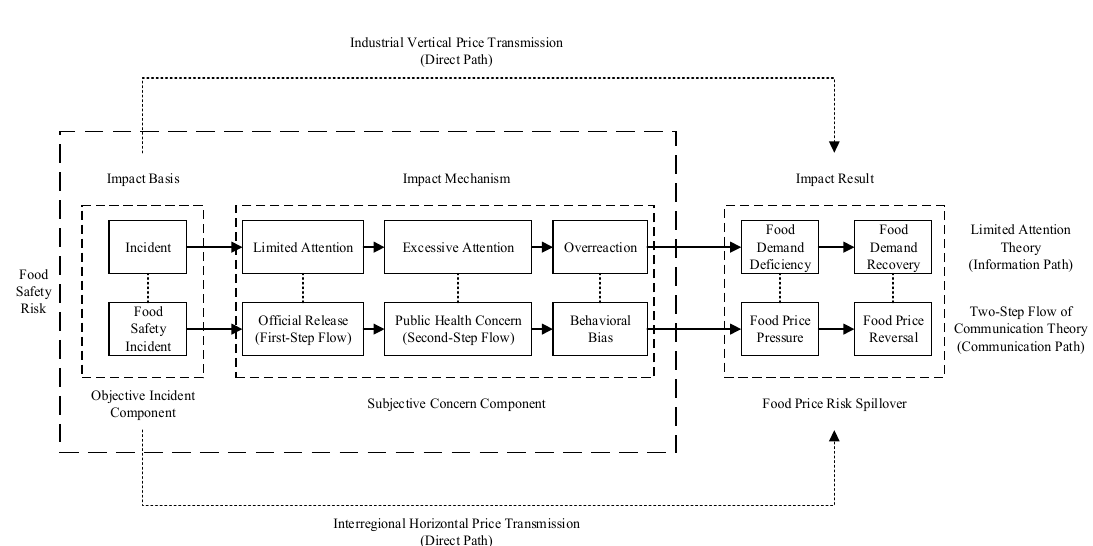
Figure 2. Theoretical framework of causality. Source: Originally developed by the authors.